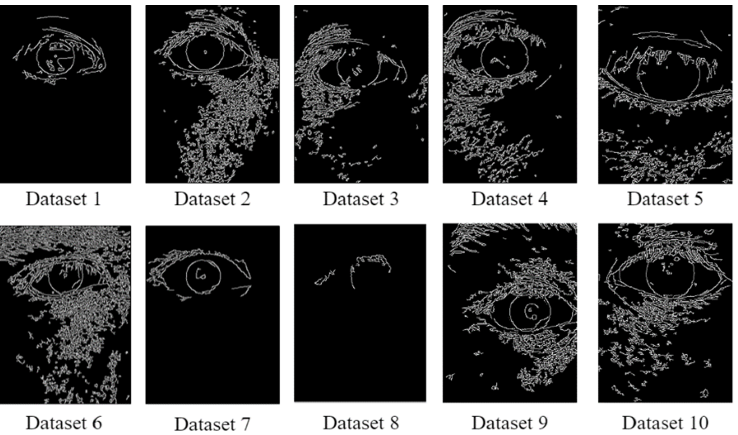
Figure 49. Results obtained for each data set through the Canny edge detector.